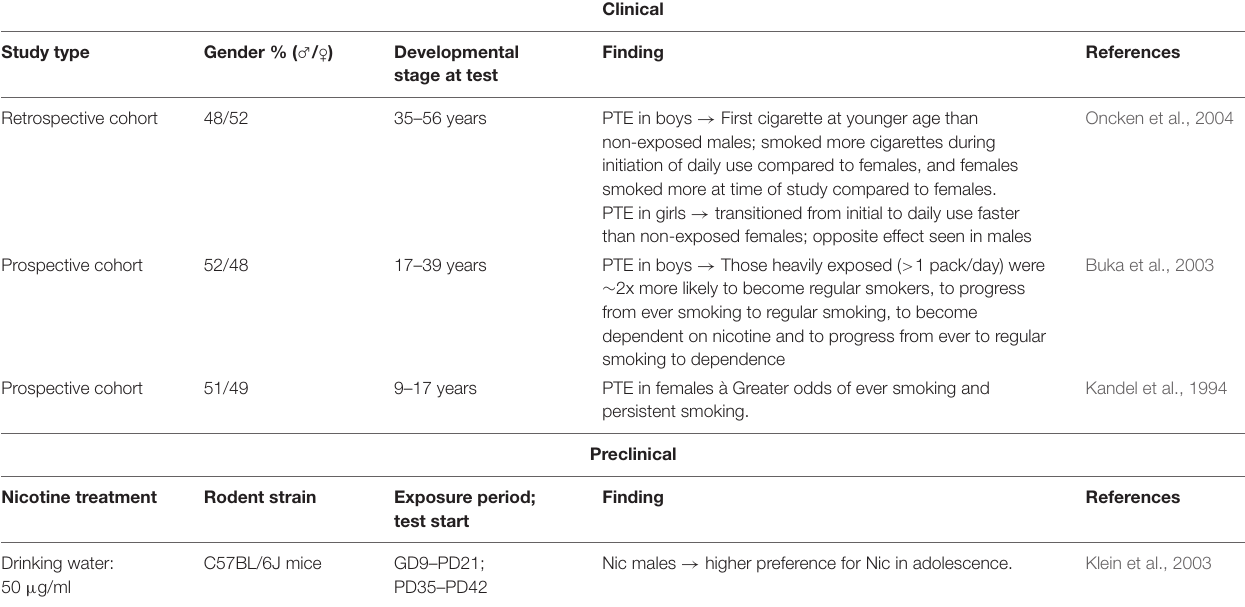
TABLE 3 | Summary of substance abuse findings in clinical and preclinical